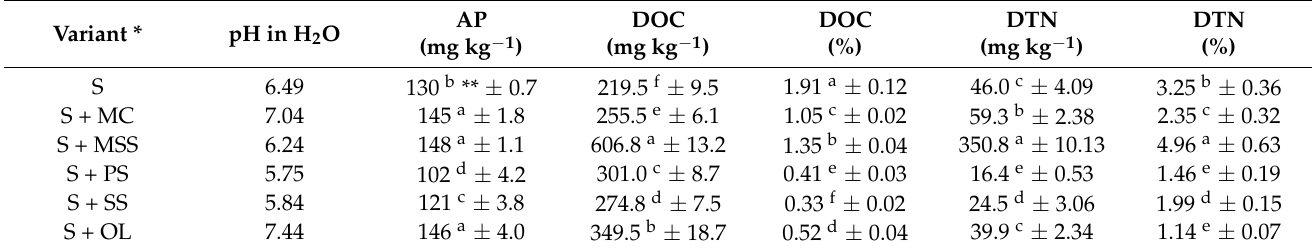
Table 3. Values of pH in H 2 O, content of available phosphorus (AP), content and share of dissolved organic carbon (DOC) and nitrogen DTN (after 60-day incubation).